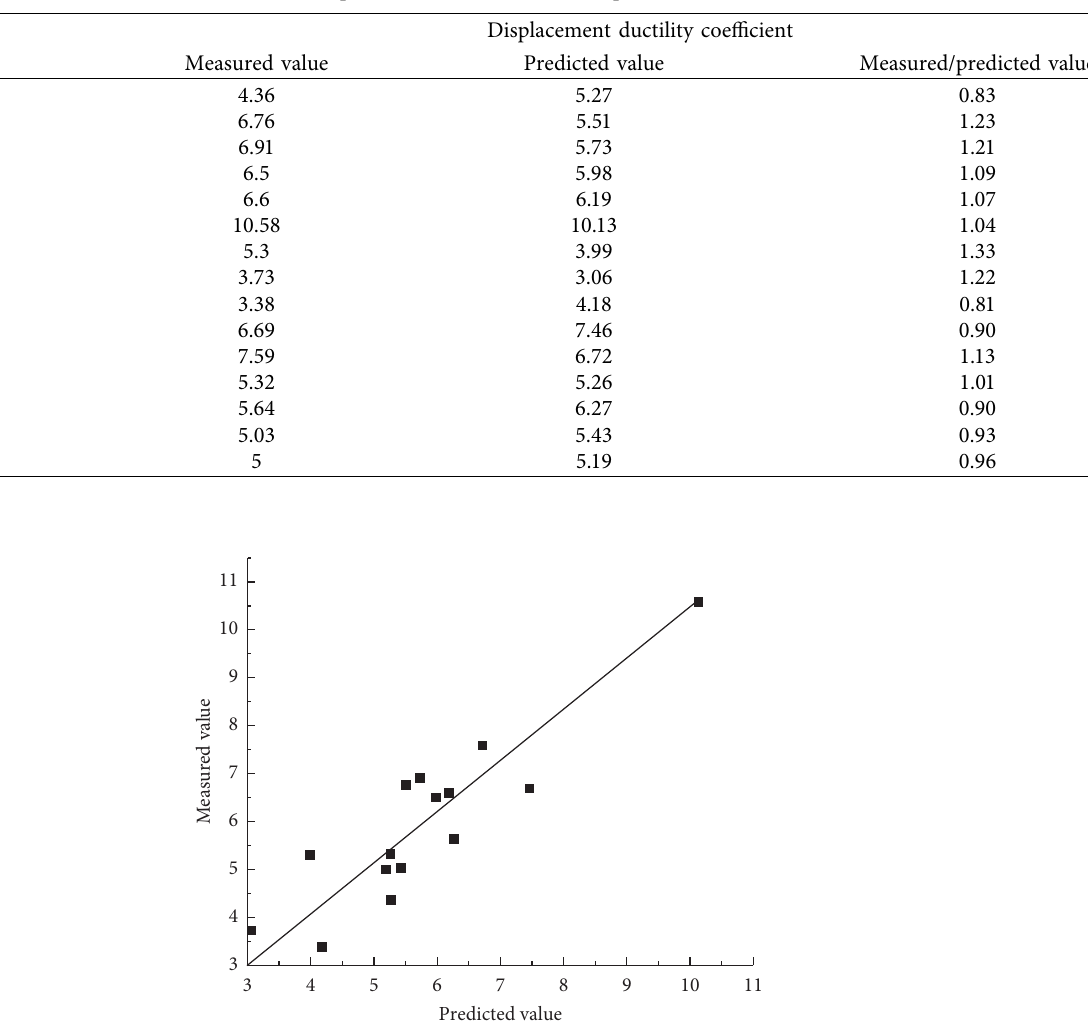
Table 10: Comparison of the measured and predicted value.